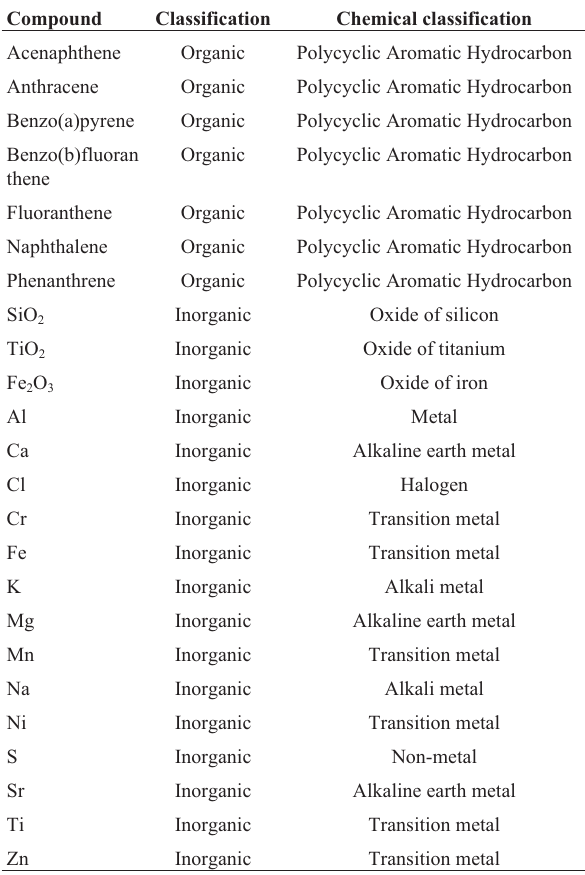
Table 1 - Chemical constituents of coal samples found in the major CPI-PPI